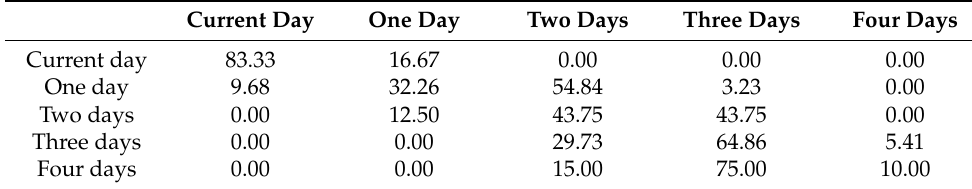
Table 6. Prediction results are based on the ratio of R in RGB values without